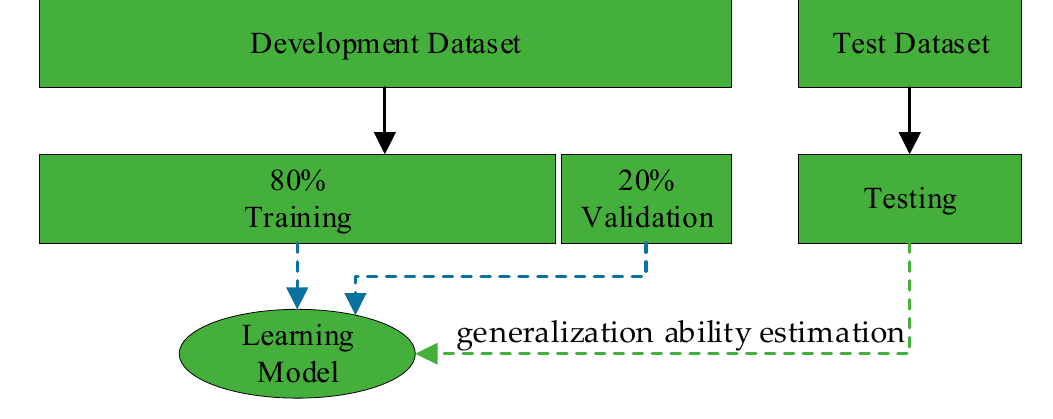
Figure 2. Dataset construction. Figure 2. Dataset